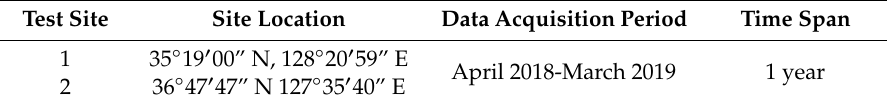
Table 1. Specifications of each test site used in this study.